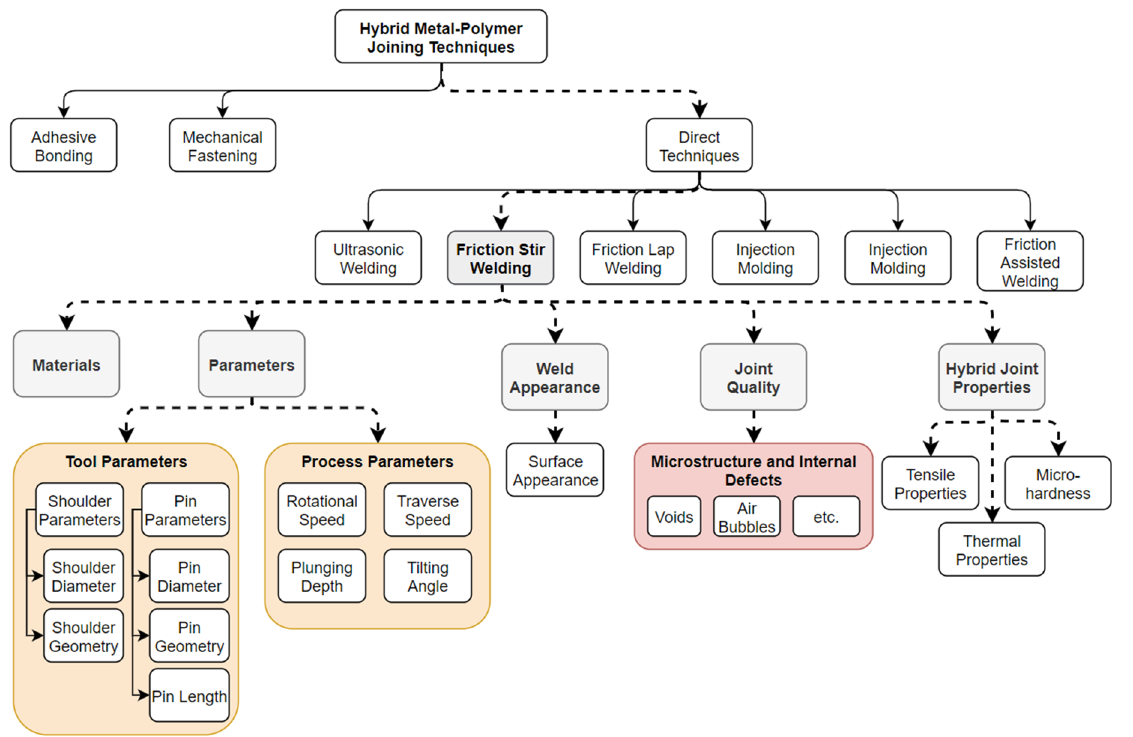
Figure 1. A summary of the topics reviewed in this work. The topics that are preceded by solid arrows are briefly reviewed, while the topics that are preceded with dashed arrows are discussed and reviewed in detail in the following sections of this work.